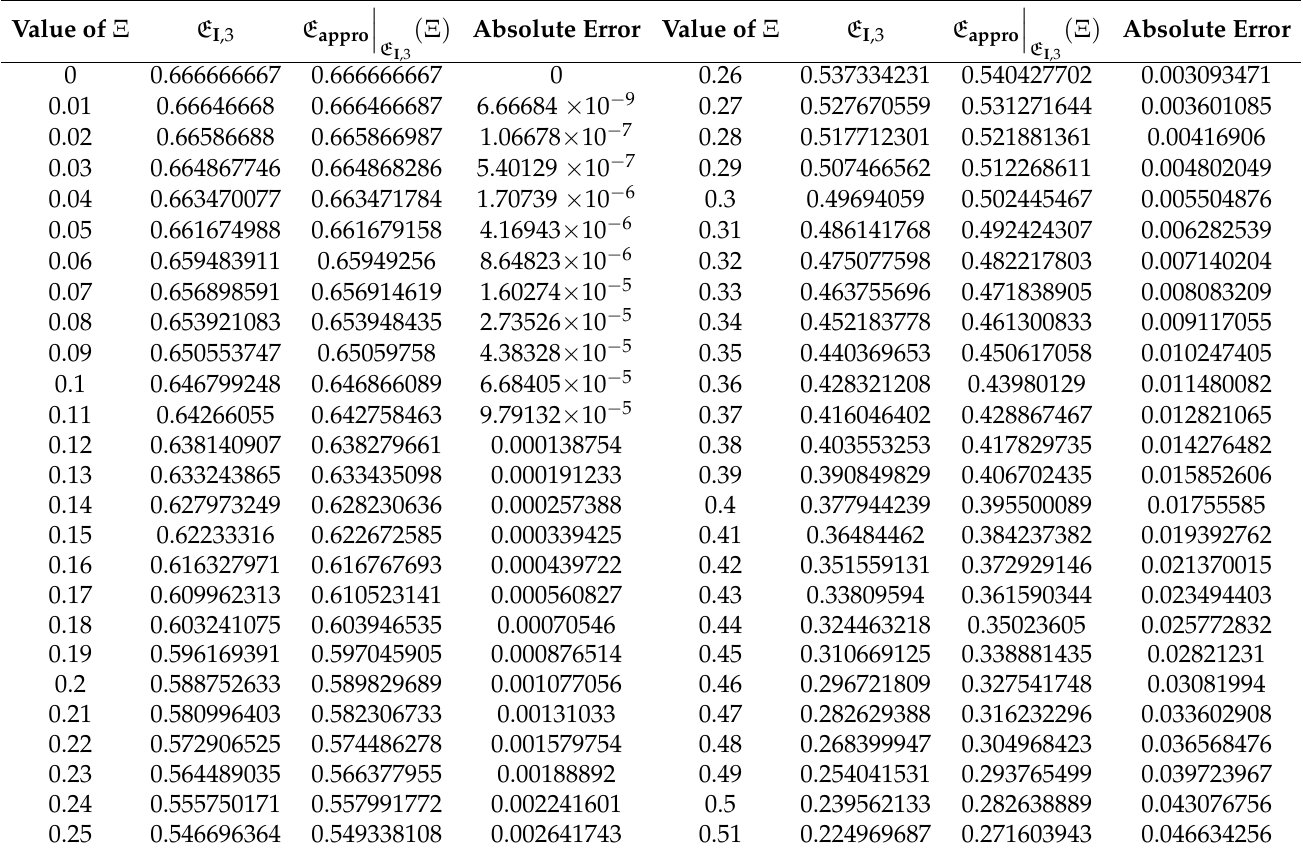
Table 1. Accuracy of the ESE method’s solutions through AD method.